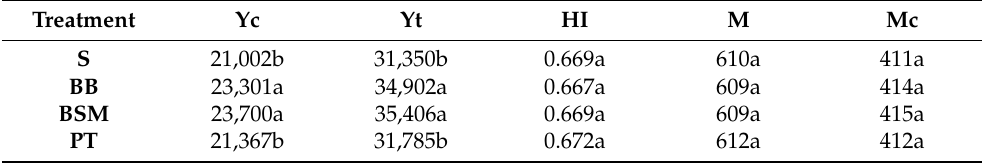
Table 5. Yield and crop quality.